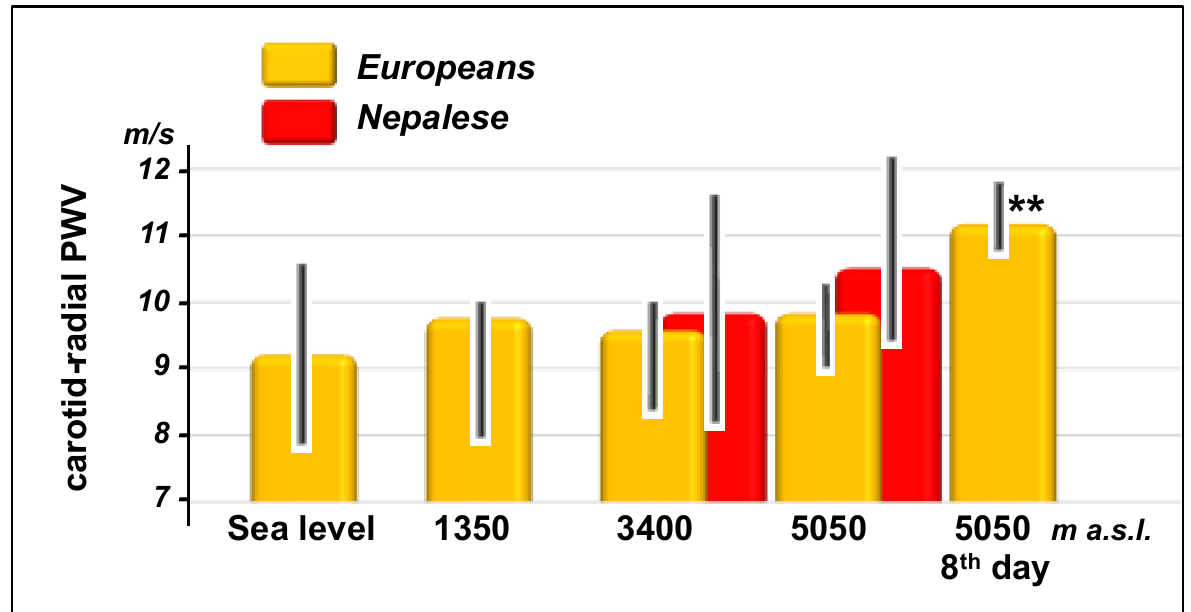
Figure 4. Changes in carotid-radial pulse wave velocity (PWV) during the ascent and stay at very high altitudes in Europeans and Nepalese. Data are shown as median and interquartile range. Significance versus basal condition (sea level for lowlanders and 3400 m a.s.l. for highlanders) is expressed by the p -value: **, p < 0.001.